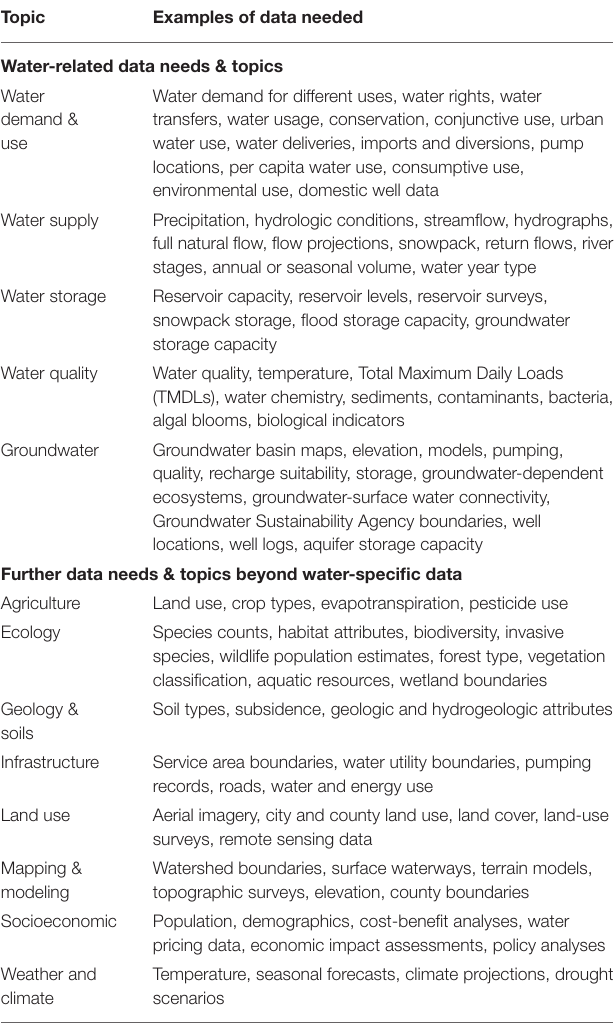
TABLE 4 | Broad range of data needs and topics represented within data needed for water decision making (adapted from Cantor et al., 2018).